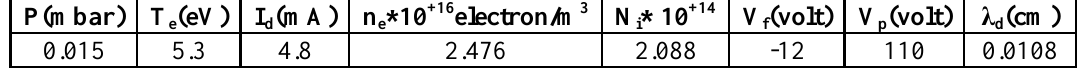
Table 1: The plasma parameters with different discharge pressure.